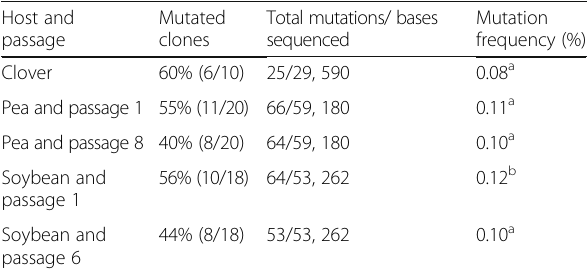
Table 2 Genetic variation in SbDV-MD6 populations in different host species and passages